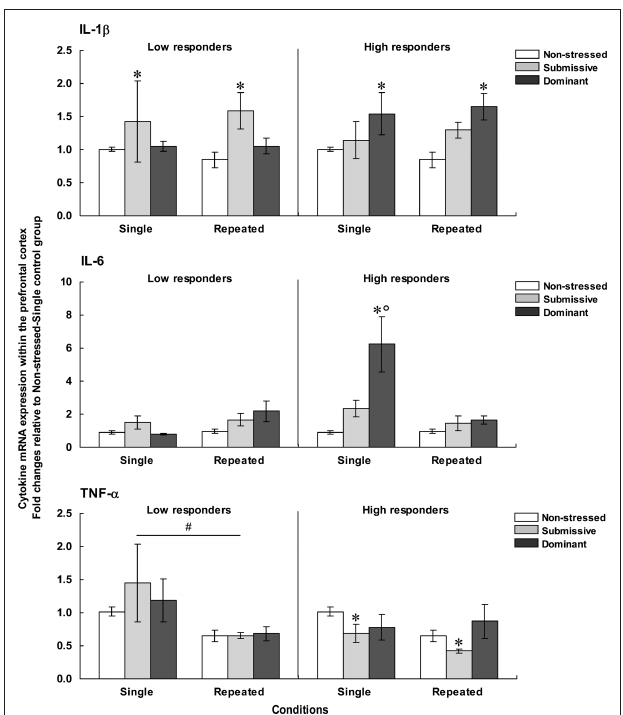
Figure 4 | Fold changes for mrNA expression of iL-1 β (top), iL-6 (middle), and TNF- a (bottom) within the PFC in non-stressed mice as well as in submissive and dominant mice engaged in single or repeated aggressive encounters. Fold changes were relative to the Non-stressed – Single control group. Data for low corticosterone responders are shown in the left panel, whereas data for high responders are reported on the right. The N /group was the same as that described in Figure 1 . Data represents means ± SEM. * p < 0.05 relative to non-stressed mice. * ° p < 0.001 relative to non-stressed and submissive mice. # p < 0.01 relative to the single condition.